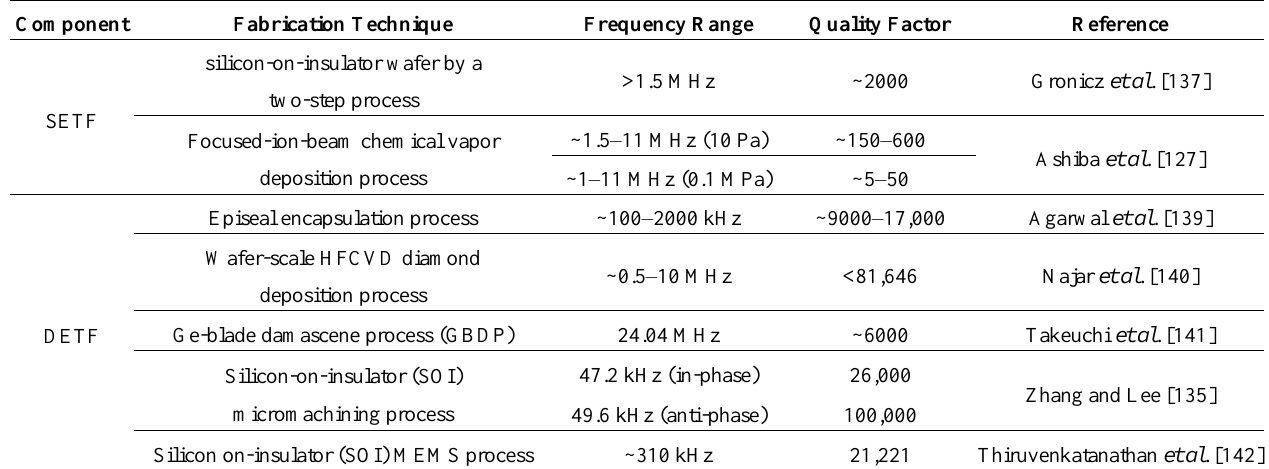
Table 2. Overview of some single-ended tuning fork (SETF) and double-ended tuning fork (DETF)